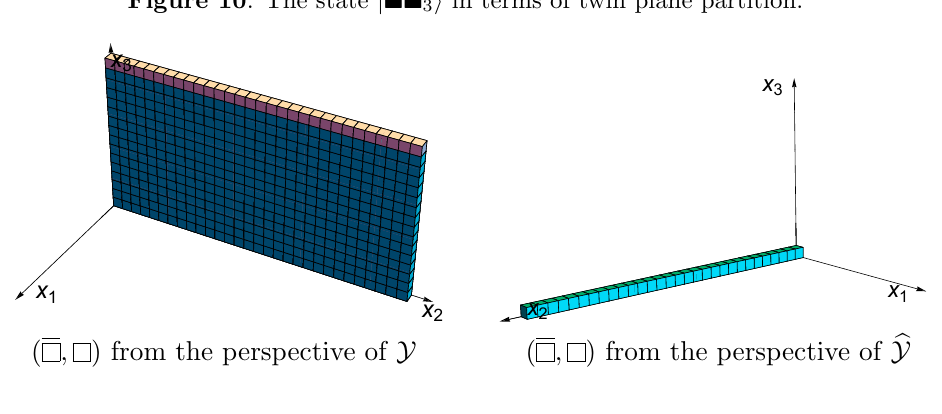
Figure 10 . The state